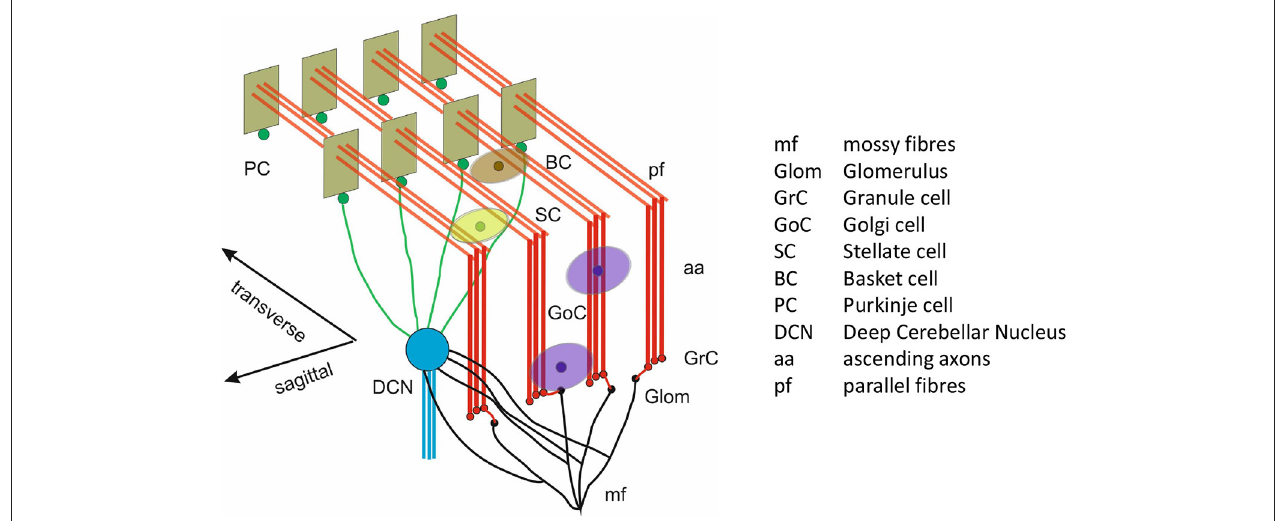
FIGURE 1 | 3D model architecture of the cerebellum. Reproduced from Casali et al. (2019) with permission.